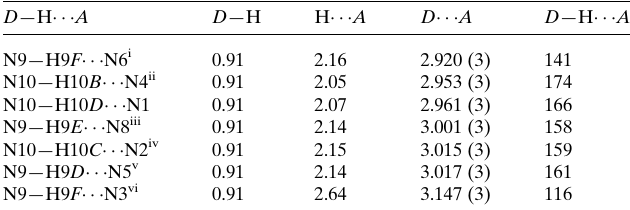
Table 2 Experimental details. Crystal data Chemical formula